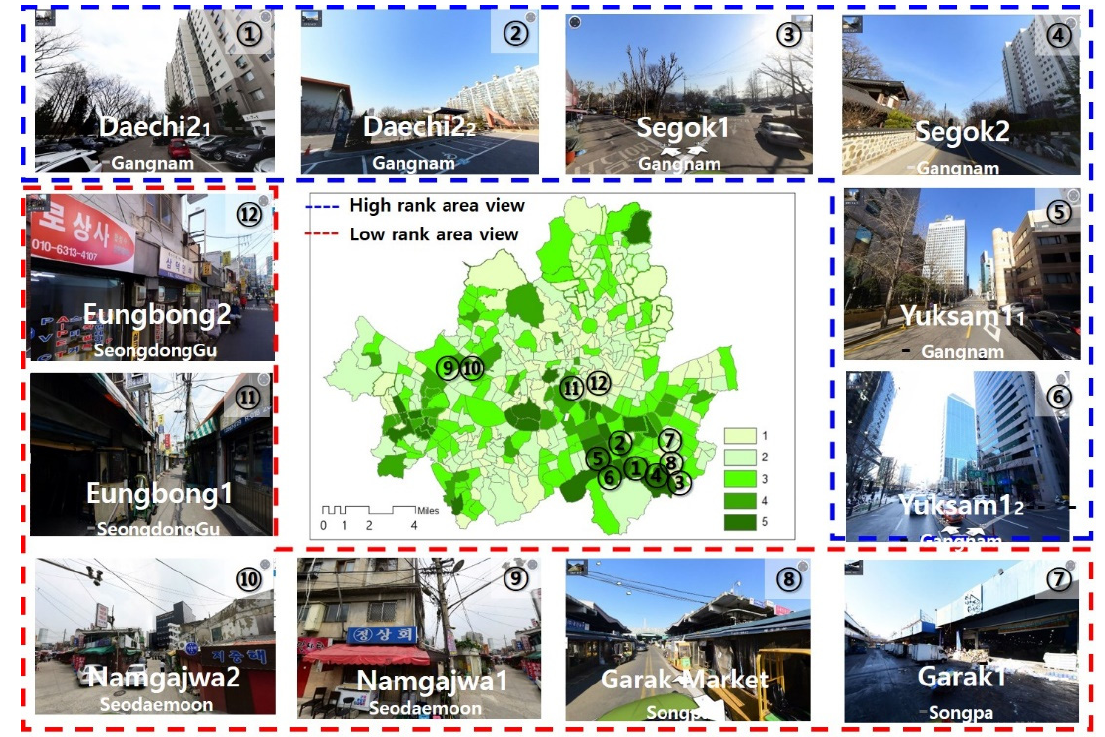
Figure A4 . Street views of top three-ranked and bottom three-ranked communities for thermal adaptive capacity.